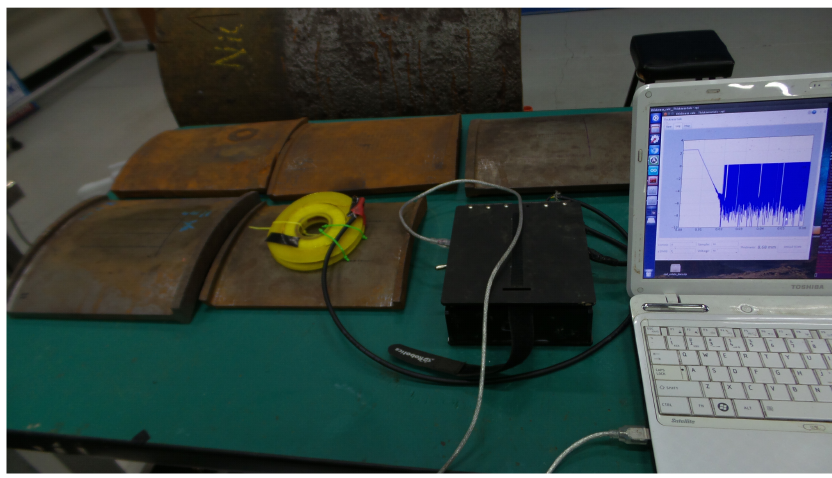
Figure 12. Experimental setup used with grey cast iron calibration blocks.